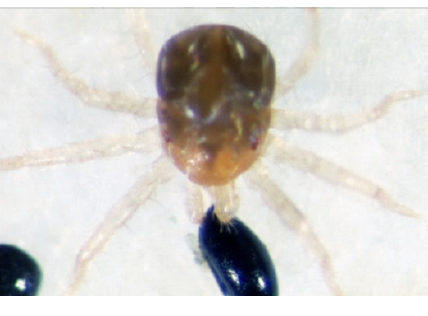
Figure 12. Anystis baccarum feeding on an overwintering Rhopalosiphum insertum egg (Photo: Andrew G. S. Cuthbertson ©